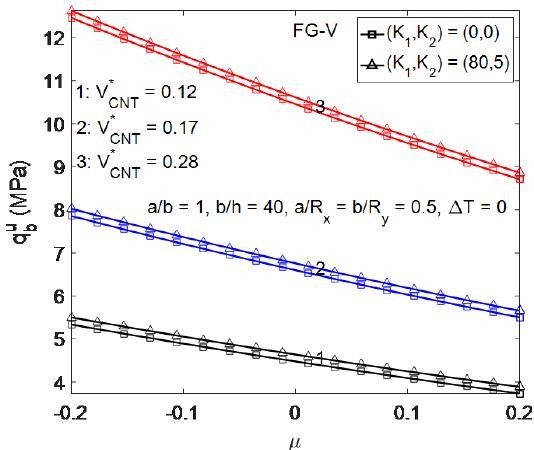
Fig. 5: Effects of CNT distribution types on the nonlinear response of CNTRC spherical panels under uniform external pressure with immovable edges.